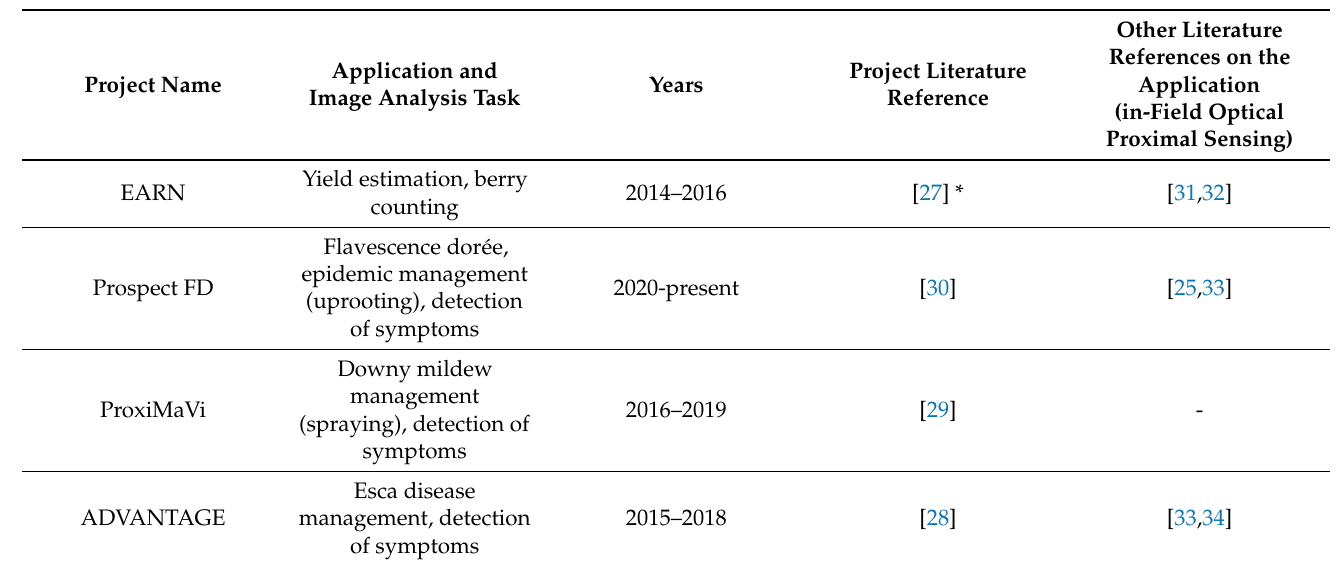
Table 1. Description of the scientific projects used in the study. When possible, references of past scientific publications are provided. (* publication covering both grapevine and apple detection